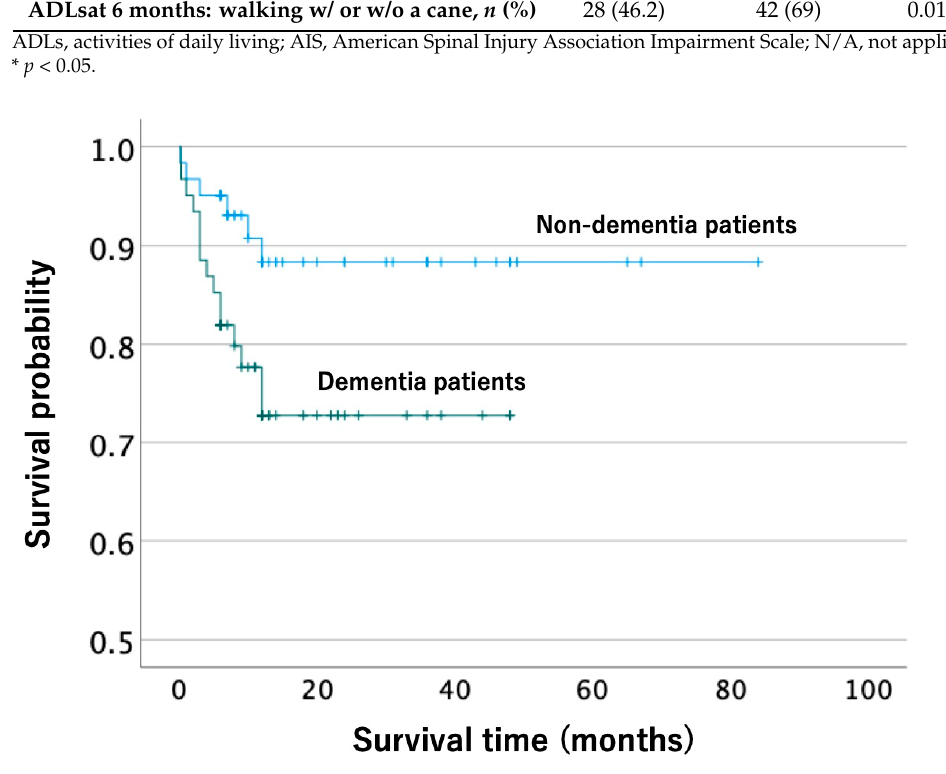
Figure 1. Kaplan–Meier survival curve showing the survival probability of patients with and with- out dementia. The mean survival time was 36.4 (95% CI: 31.4–41.5) months in the dementia group and 74.9 (95% CI: 68.0–81.8) months in the non-dementia group. The log-rank test revealed that patients with dementia had a lower survival rate than those without dementia (log-rank test: p = 0.031). CI, confidence